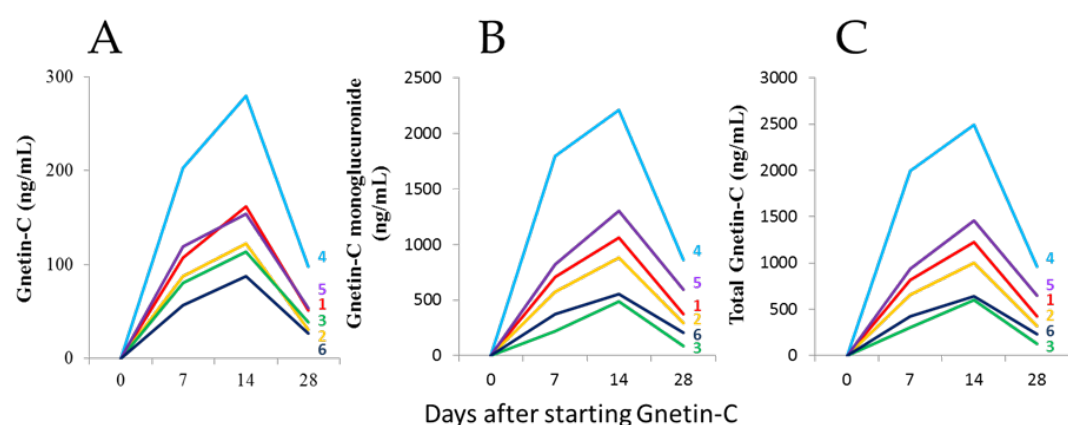
Figure 2. ( A ) Plasma concentrations of Gnetin-C; ( B ) the Gnetin-C metabolite, Gnetin-C monoglucuronide; ( C ) total Gnetin-C before and after Gnetin-C supplementation. In ( A – C ), subject 1 is shown in red, subject 2 in orange, subject 3 in green, subject 4 in light blue, subject 5 in purple, and subject 6 in blue.